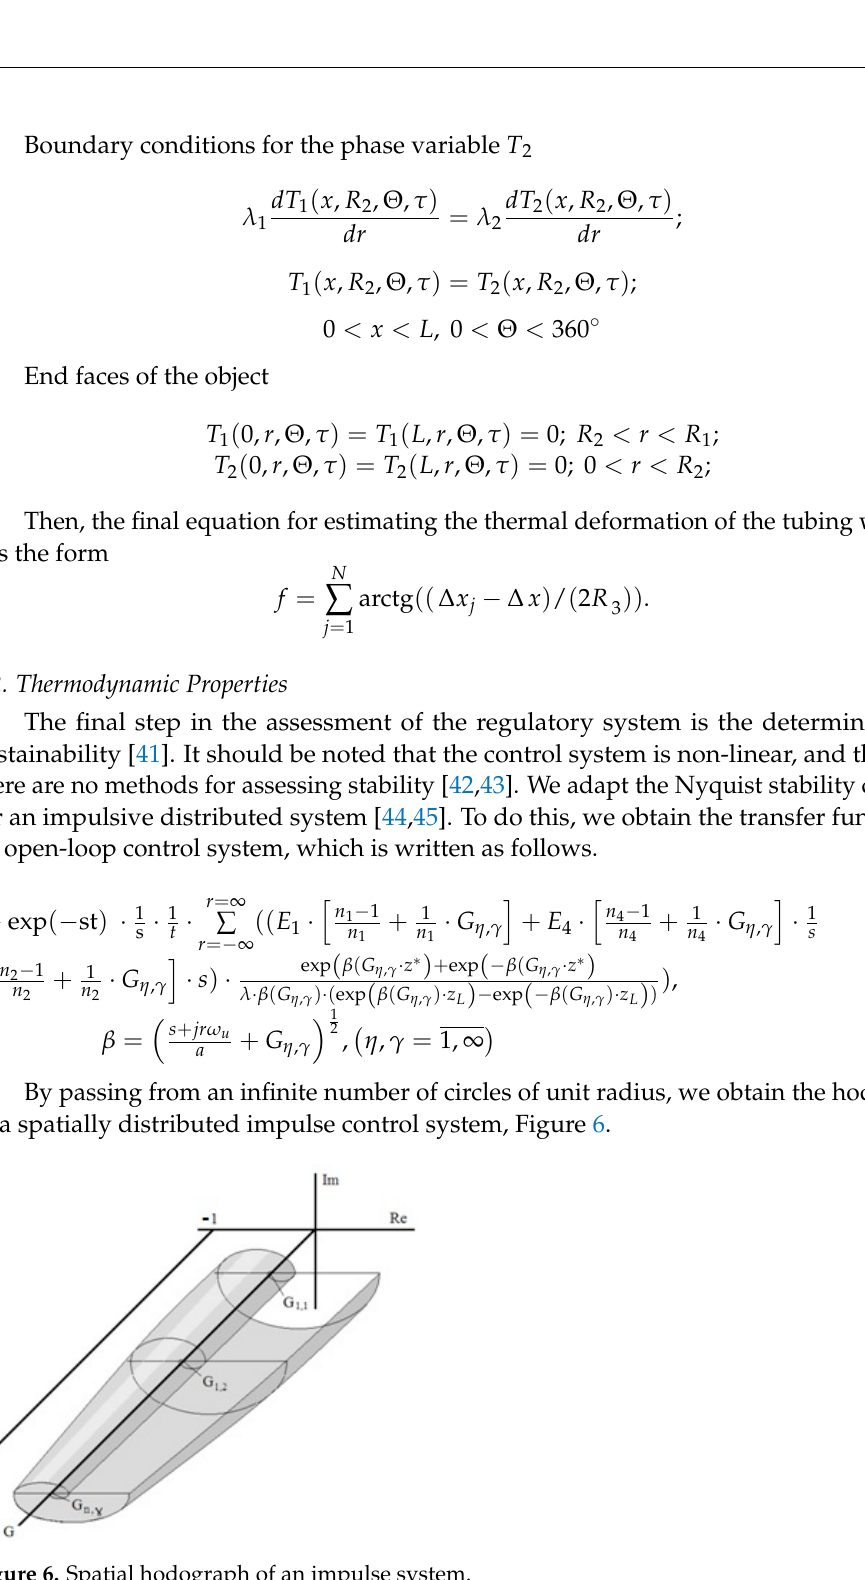
Figure 6. Spatial hodograph of an impulse system.